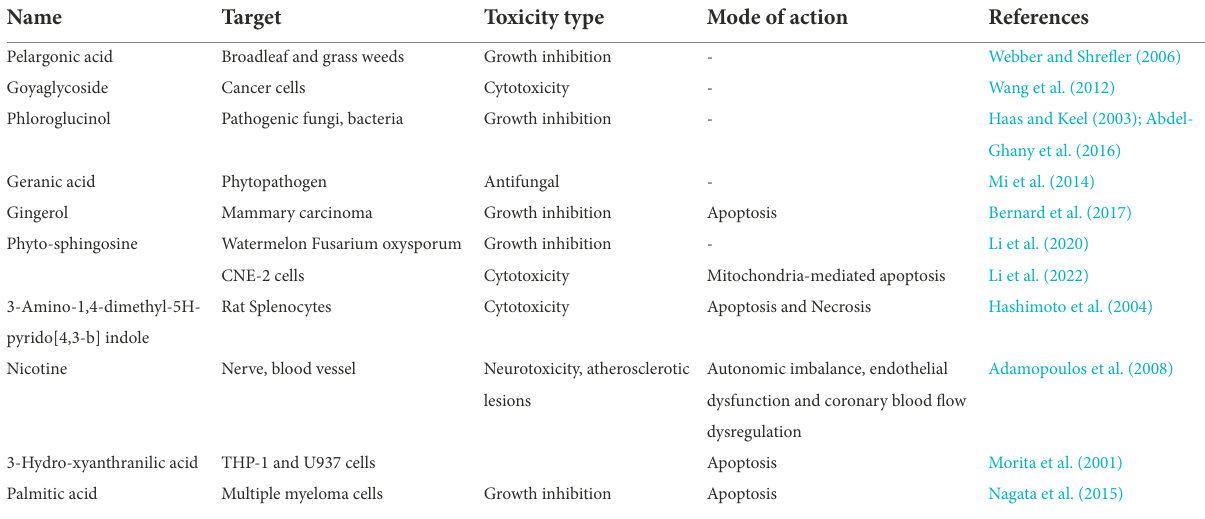
TABLE 2 Main compounds identified and their toxicologic